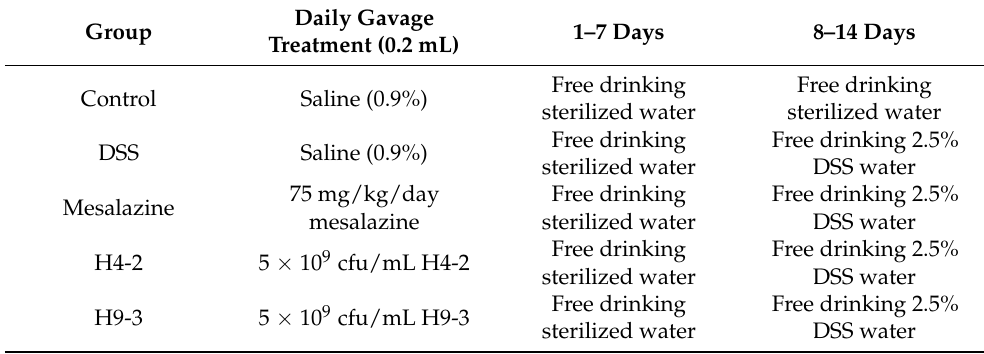
Table 1. Animal model experimental design.